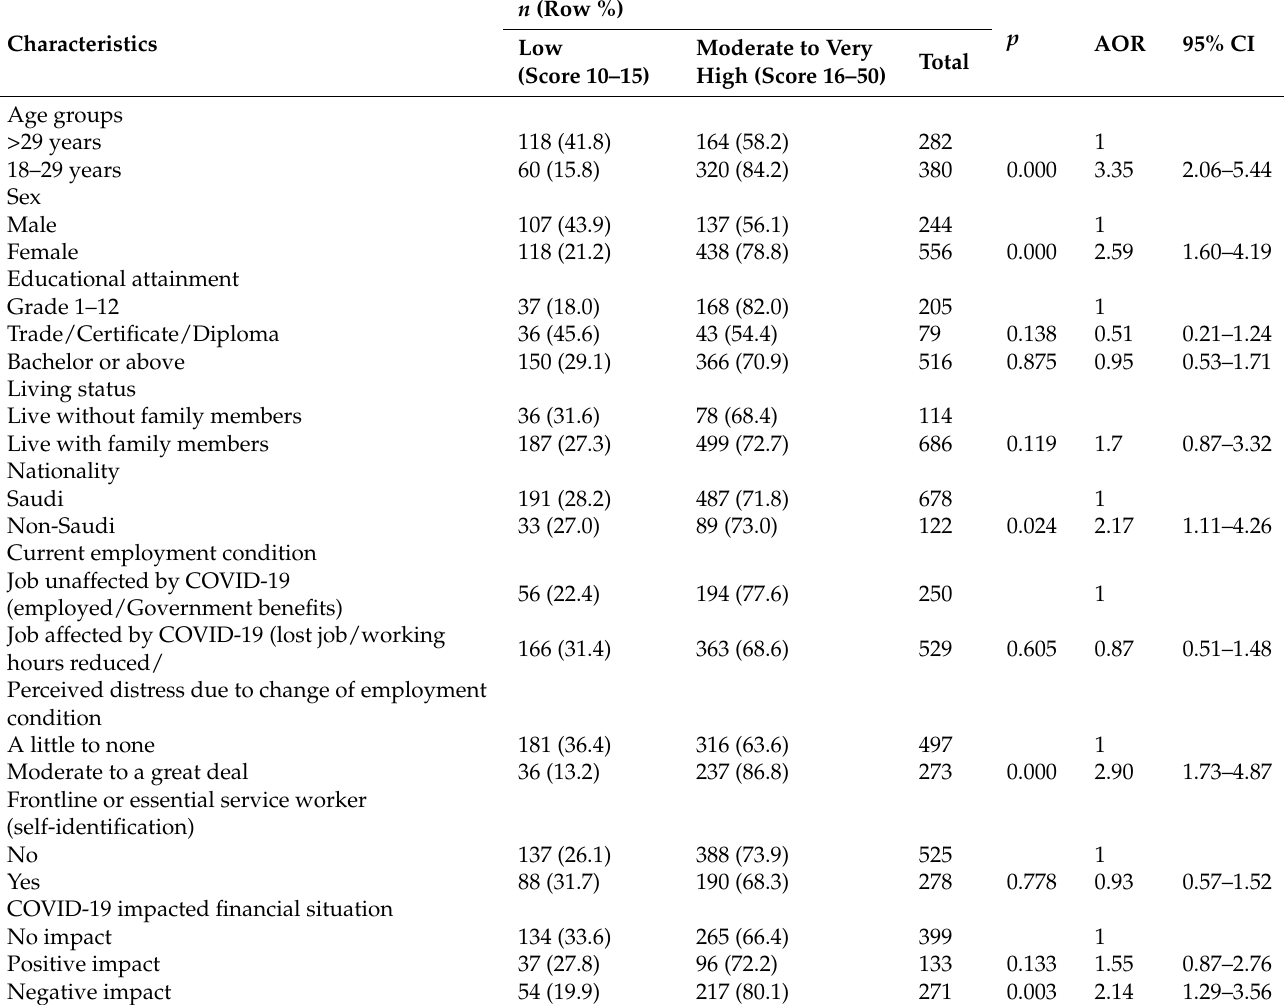
Table 3. Factors associated with psychological distress among adults in Saudi